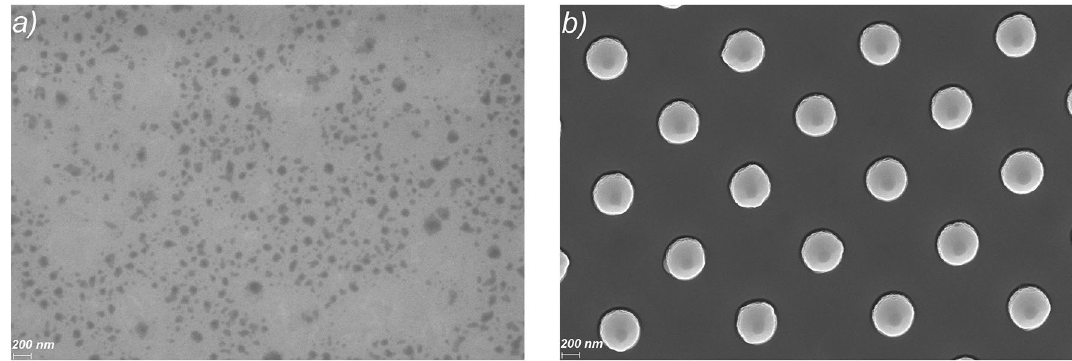
Figure 3. SEM images of the ITO films deposited on flat ( a ) and nano-patterned ITO ( b